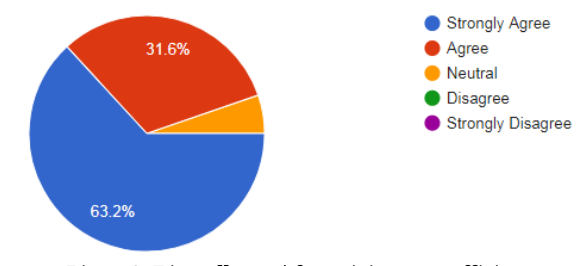
Figure 8: Time allocated for training was